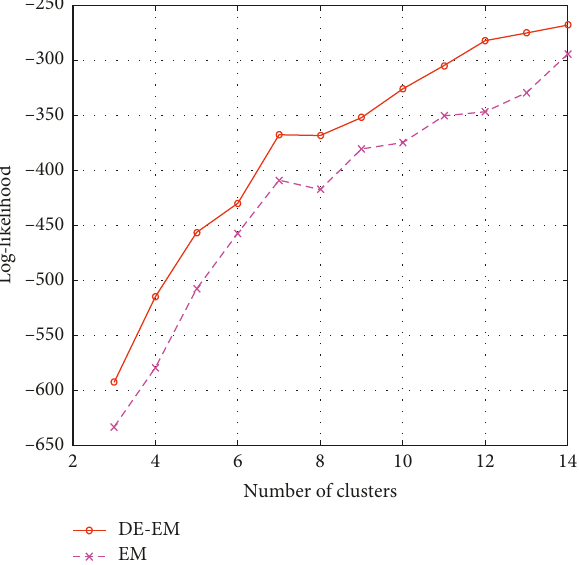
Figure 4: Log-likelihood with different